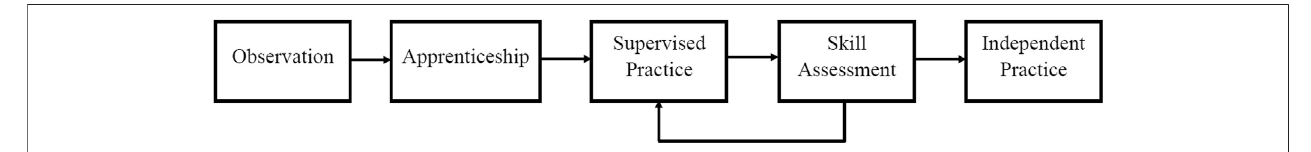
FIGURE 1 | Process of procedural skill development in medical training and